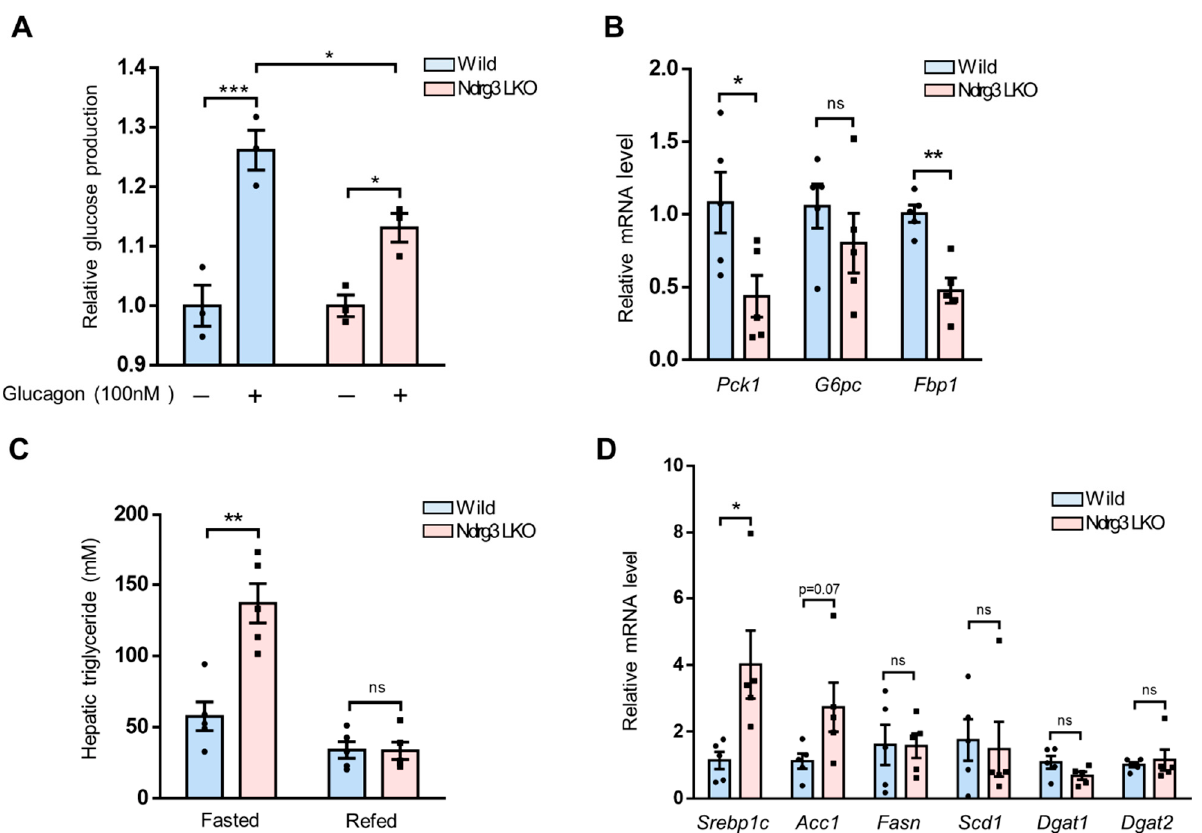
Figure 5. Alterations in hepatic gluconeogenesis and lipogenesis in Ndrg3 LKO mice. ( A ) Quantitative measurement of hepatic glucose production under a gluconeogenic condition. Primary hepatocytes isolated from 2-month-old wild-type and Ndrg3 LKO mice ( n = 3 per group) were cultured, subjected to serum and glucose starvation overnight, and stimulated with glucagon (100 nM) for 4 h. Glucose production rate of glucagon-stimulated primary hepatocytes was expressed as the fold change relative to vehicle-treated hepatocytes. ( B ) qRT-PCR analysis of gluconeogenic gene expression in wild-type and Ndrg3 LKO mouse livers at 2 months of age in the fasting condition ( n = 5 per group). ( C ) Liver triglyceride levels of 2-month-old wild-type and Ndrg3 LKO mice were determined ( n = 5 per group). Mice were fasted overnight before being subject to the triglyceride analysis. ( D ) qRT-PCR analysis of lipogenic gene expression in wild-type and Ndrg3 LKO mouse livers at 2 months of age ( n = 5 per group). Gene expression was normalized using Rpl32 ( B ) or Gapdh ( D ) as the reference. Data are presented as mean ± SEM. p-values were calculated using two-way ANOVA followed by Tukey’s multiple comparisons test ( A ) or two-tailed Student’s t -test ( B – D ). * p < 0.05, ** p < 0.01, and *** p < 0.001 vs . wild-type mice. 3.6. NDRG3 Depletion Perturbs Methionine Metabolism in Mouse Hepatocytes We carried out metabolome profiling on mouse liver extracts via CE-TOFMS to quantitatively assess alterations in metabolite level downstream of NDRG3 ablation. Principal component analysis (PCA) and one-way hierarchical clustering analyses showed a clear separation of metabolome profiles for Ndrg3 LKO and WT livers (Figure S6A,B). Sixty-nine metabolites satisfying (log 2 (fold change)>1, p -value < 0.05) in Ndrg3 LKO relative to WT were selected (Figures 6A and S6C) for metabolite set enrichment analysis (MSEA) using the MetaboAnalyst 5.0 program [20] (Figure 6B). Among top- ranked metabolite sets, those related to ‘methionine’ metabolism were highly enriched, including metabolomes of ‘methionine metabolism’, ‘glycine and serine metabolism’,